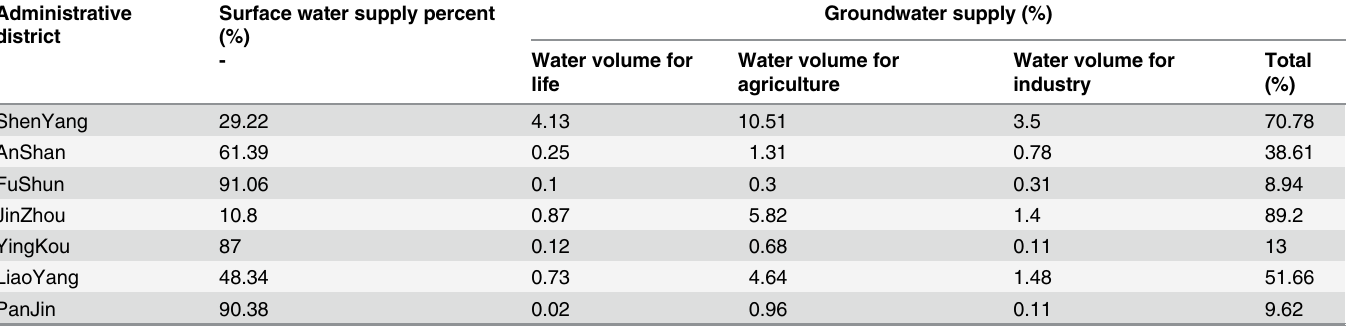
Table 4. The groundwater supply status of the study